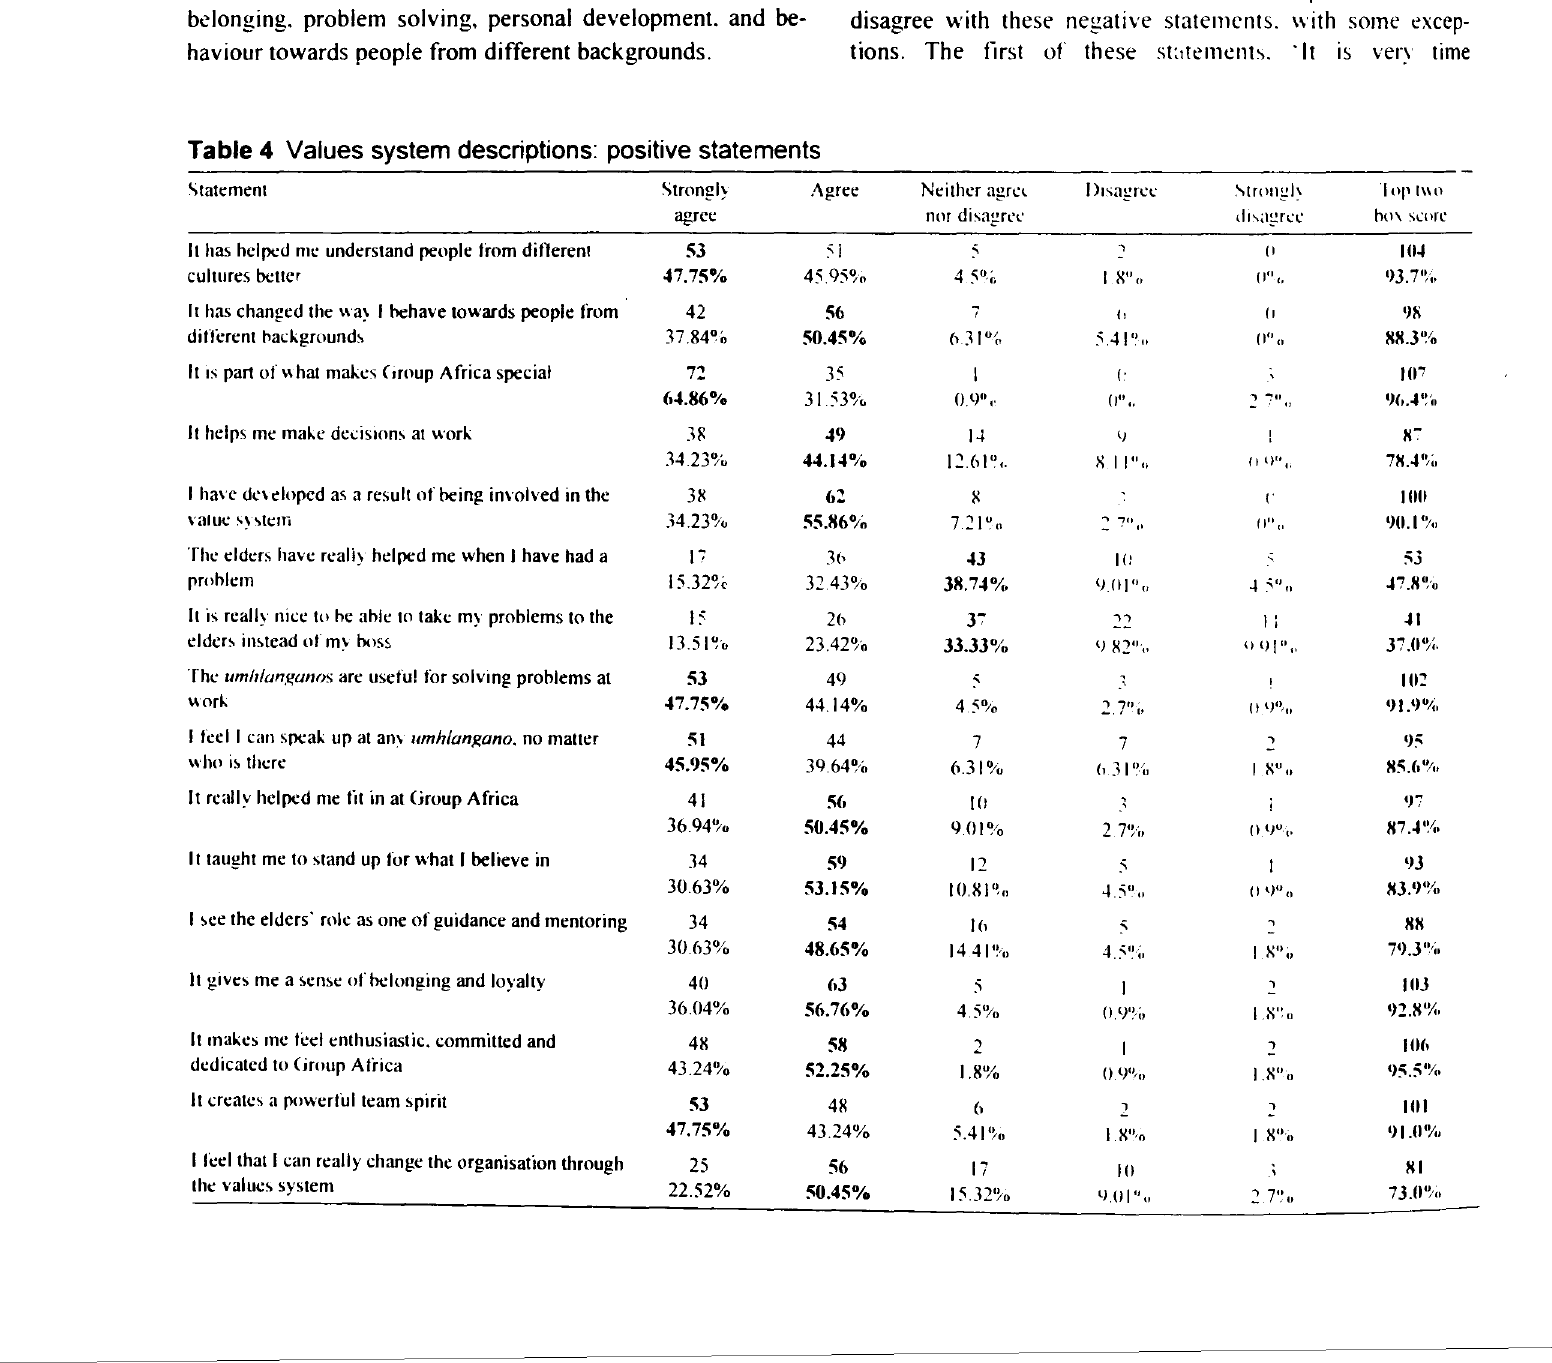
Table 4 Values system descriptions: positive